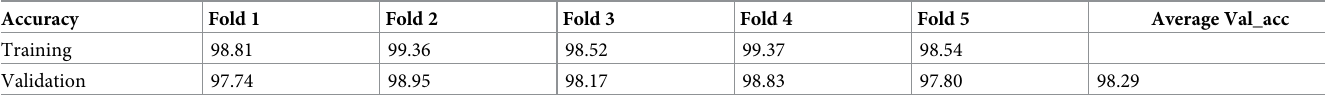
Table 20. Result of 10-Fold cross-validation on the dataset before applying augmentation. Accuracy Fold 1 Fold 2 Training 97.34 Validation